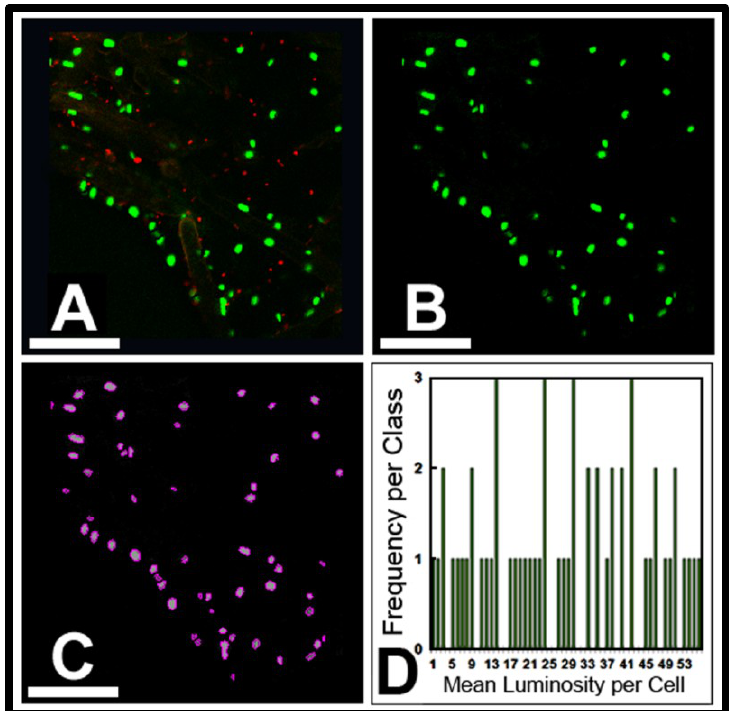
Figure 15. Variation in intensity of gfp gene expression activated by bacterial cell-to-cell communication between neighboring cells of Pseudomonas putida reporter strains colonized on a wheat root. ( a ): Laser scanning confocal micrograph of a flattened Z-series of optisections of red-fluorescent ―signal source‖ cells and green-fluorescent ―signal sensor‖ cells communicating with each other via N-acylhomoserine lactones. ( b ) : Green color-segmented and ( c ) grayscale annotated images derived from Figure 15 a to measure the communication response. ( d ) Frequency distribution of the mean luminosity of Gfp fluorescence per sensor cell as an in situ measure of the variation in intensity of cell-to-cell communication at single-cell